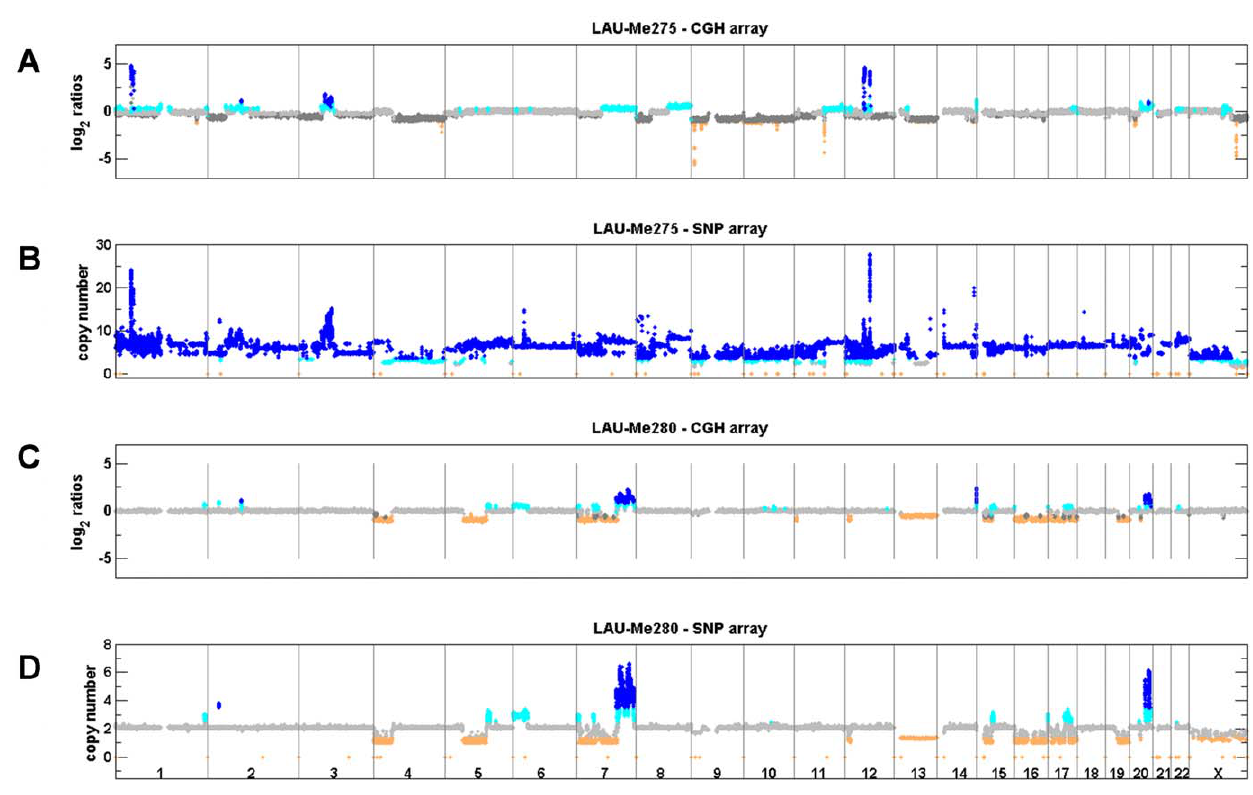
Figure 2. Copy number analysis using CGH and SNP arrays. A. and B. shows the analysis of LAU-Me275 on CGH and SNP arrays. C. and D. shows results for LAU-Me280. Probe/SNP are plotted as a function of their genomic position on the X axis. Y axis for CGH arrays corresponds to hybridization ratios. Y axis for SNP arrays corresponds to the predicted copy number. Colors indicate a copy number state (orange , 2 copies; gray=2 copies; cyan=3 copies; dark blue . 3 copies). Dark gray in the CGH panels indicates regions identified as diploid in the analysis, but where the karyotype analysis indicated copy neutral or deleted states, possibly due to cell heterogeneity.